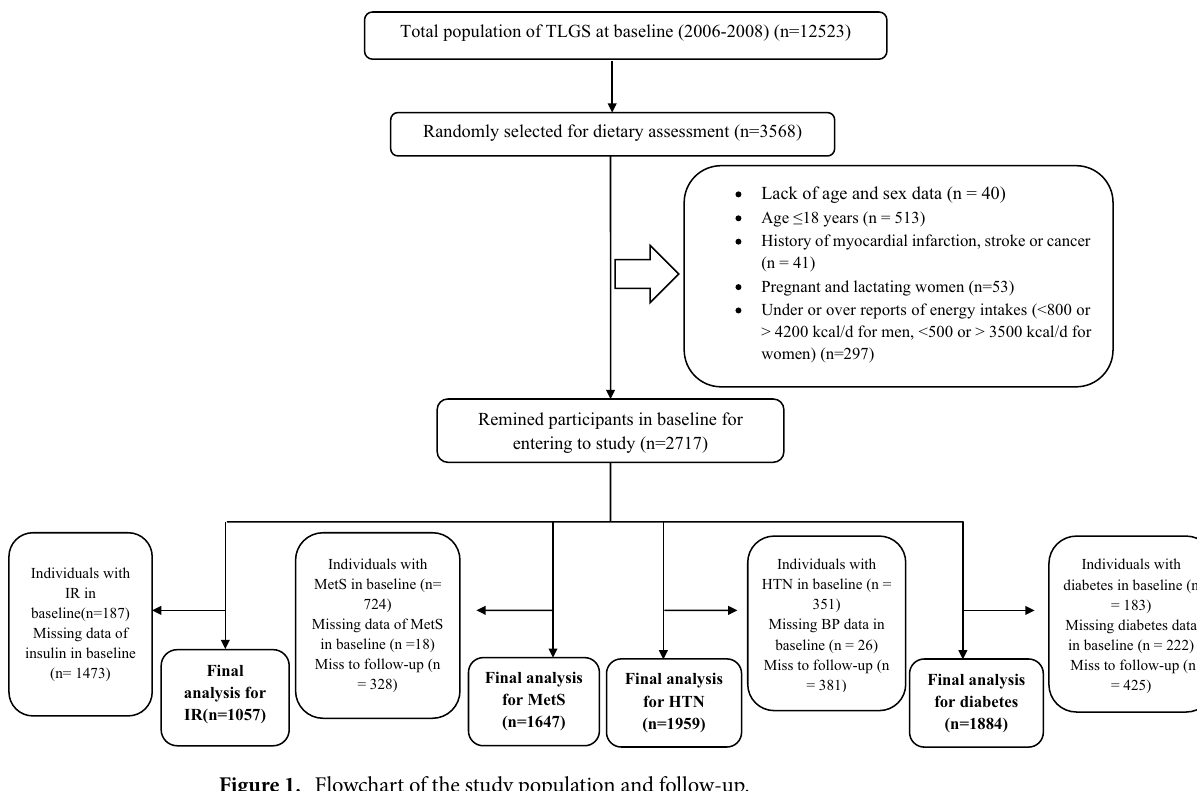
Figure 1. Flowchart of the study population and